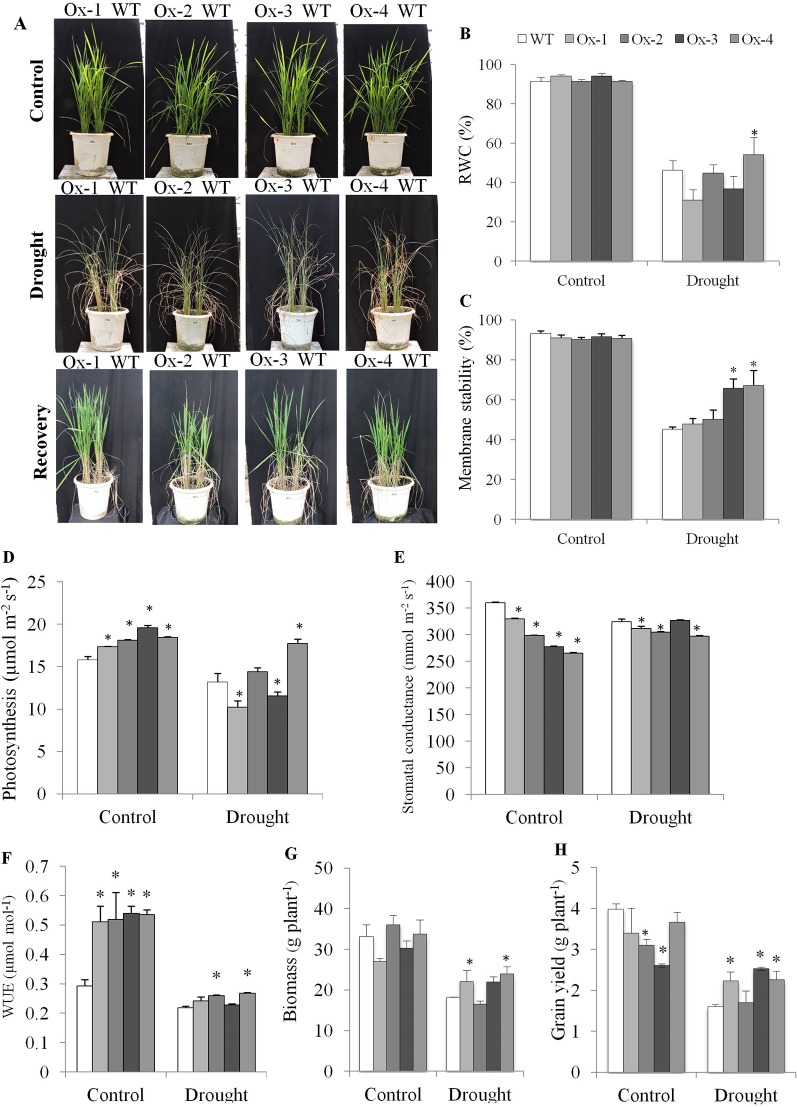
Evaluation of drought tolerance in OsPYL10 overexpressing transgenic rice at vegetative stage. (A) Phenotype of transgenic and WT plants under drought stress and recovery. Drought (∼ -80 kPa) was exposed to transgenic and WT plants by withholding water and recovered by rewatering. (B–E) Relative water content, membrane stability and photosynthesis of plants under control and drought. (F–H) WUE, plant biomass and grain yield at maturity of plants control and drought stress. The experiments were performed with three biological replicates (n = 3). Error bar indicates ±SE. *means P < 0.05.